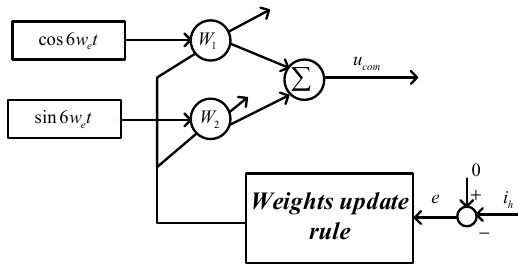
Figure 5. Block diagram of the ADALINE network.